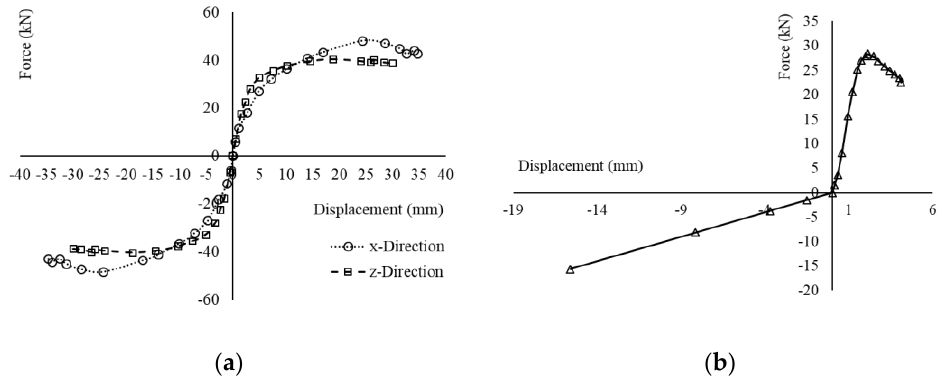
Figure 9. Load – displacement relationship for the screwed connection: ( a ) x and z direction; ( b ) y direction ( − ve is upward and +ve is pull-out